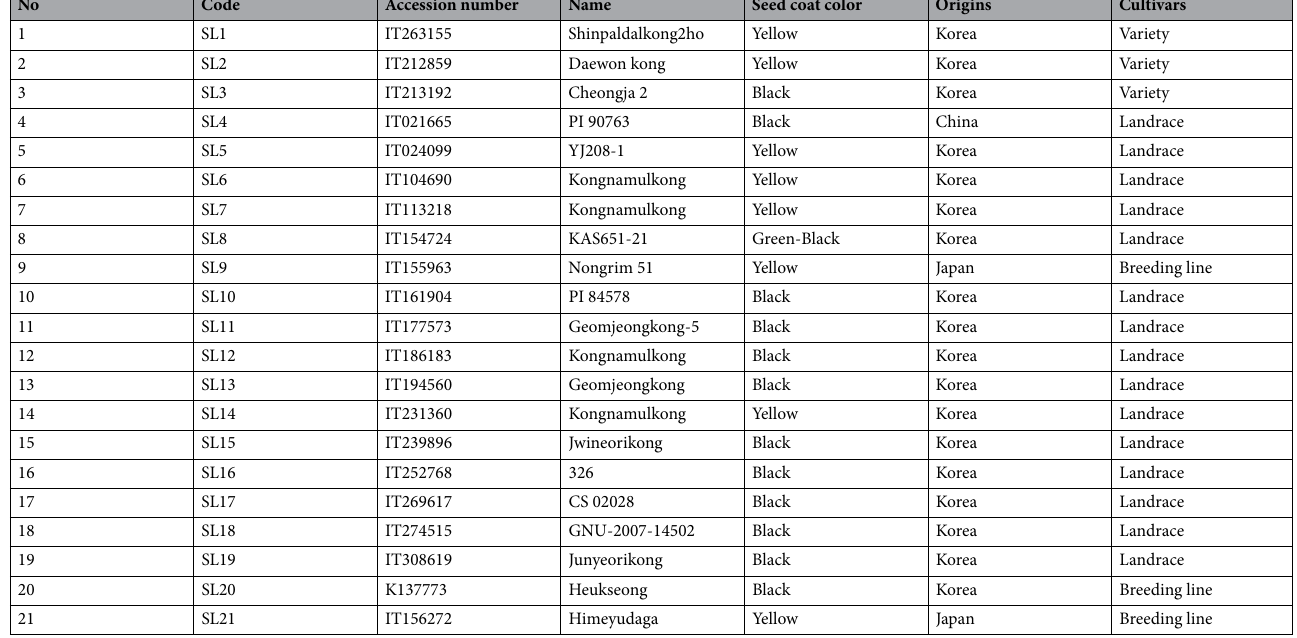
Table 3. Characteristics of core collected soybean cultivars used in the present